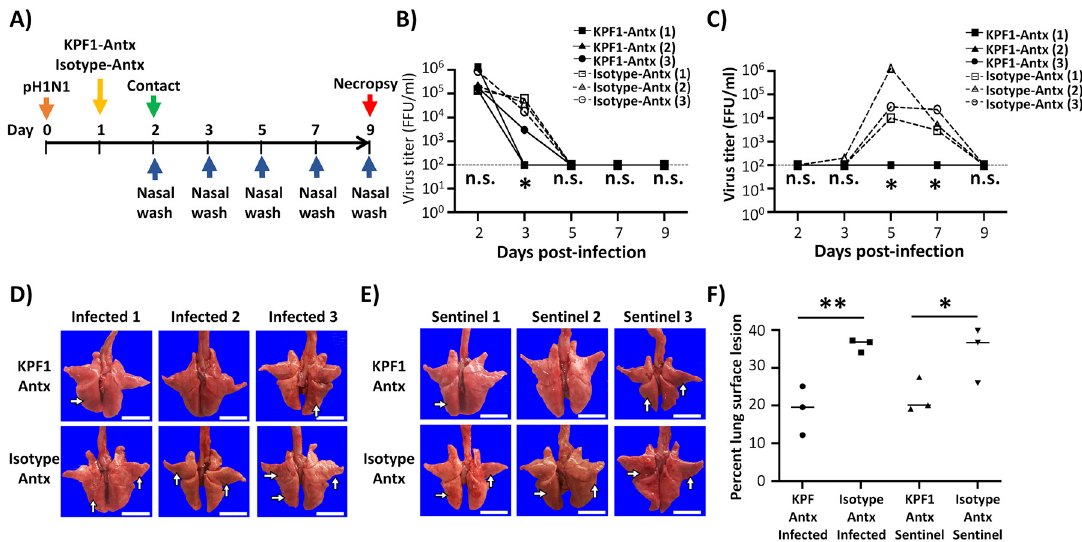
Figure 5. Therapeutic activity of KPF1-Antx hMAb in guinea pigs against pH1N1. ( A ) Schematic representation of the experimental approach: Female Hartley guinea pigs ( n = 3) were infected (i.n.)